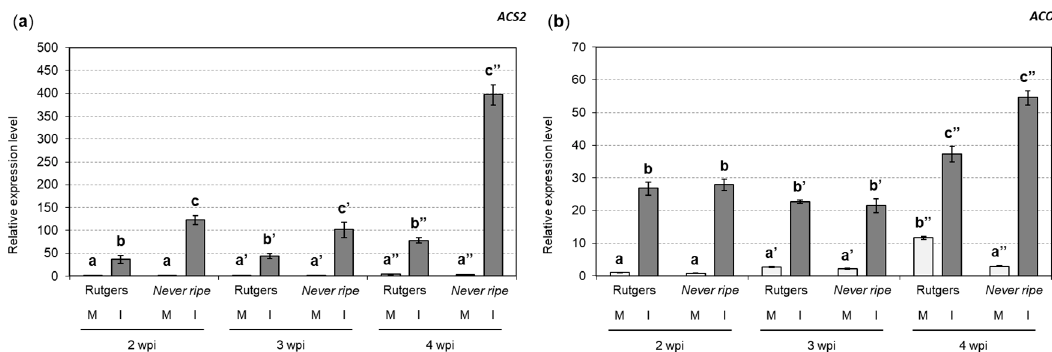
Figure 6. mRNA expression of ethylene biosynthesis enzymes in Rutgers and Nr plants from mock (M) and CEVd infected (I) plants determined by qRT-PCR, at 2, 3, and 4 weeks post inoculation (wpi). Relative expression levels of both ( a ) ACS2 and ( b ) ACO1 genes. Expression levels are relative to Rutgers mock plants and normalized to the tomato actin gene. Data correspond to the mean of at least two independent plants ± SD of at least three technical replicates. Results from one representative experiment are shown. Data were analyzed using a Mann–Whitney test and di ff erent letters indicate significant di ff erences ( p < 0.05). Number of ( ’ ) indicates di ff erent weeks.